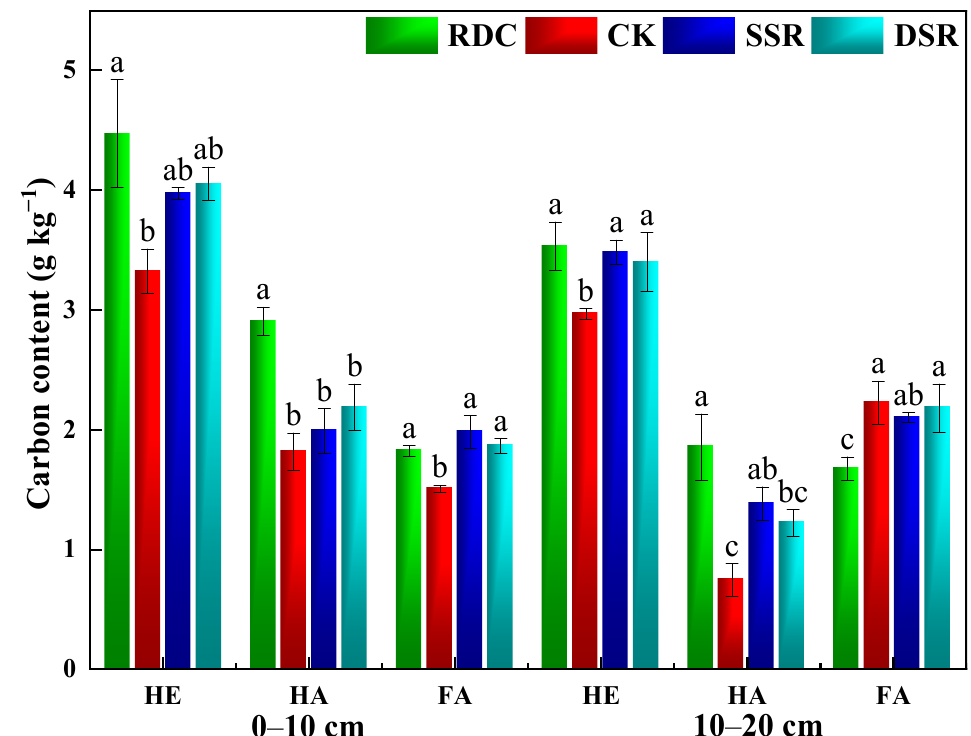
Figure 4. Effects of different planting patterns on the soil humus level and its components. HE, extractable humus; HA, humic acid; FA, fulvic acid. Small letters show the significant difference. HA/FA indicates the degree of humus condensation in soil; the higher the value is, The E4/E6 ratio and Δ log 𝑘 values are the optical properties that indicate the molec- the more active and complex the soil humus structure [45,46]. The PQ value (HA/HE) represents the relative formation rate and the conversion relationship between humic acid and humus in the soil [47]. The trends of the PQ value and HA/FA value were found to